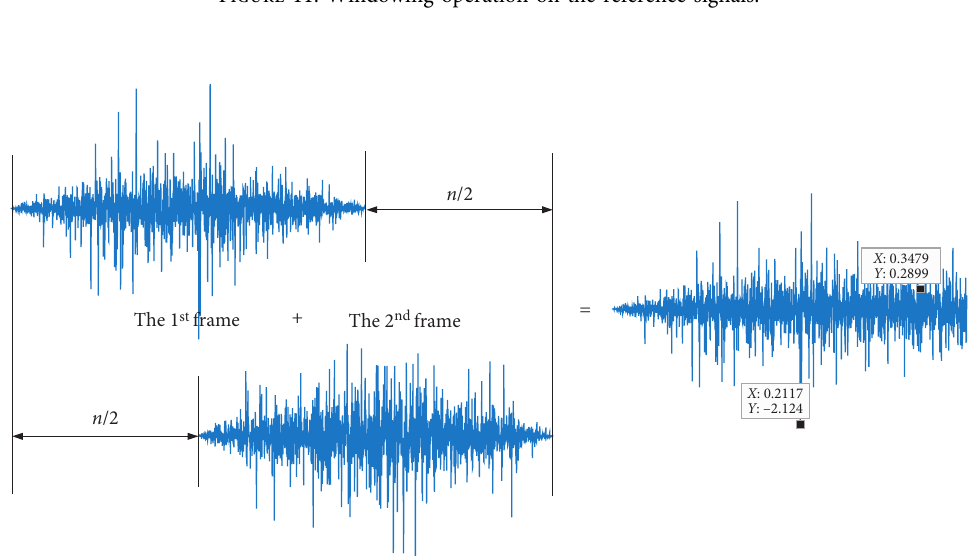
Figure 12: OLA operation on the reference